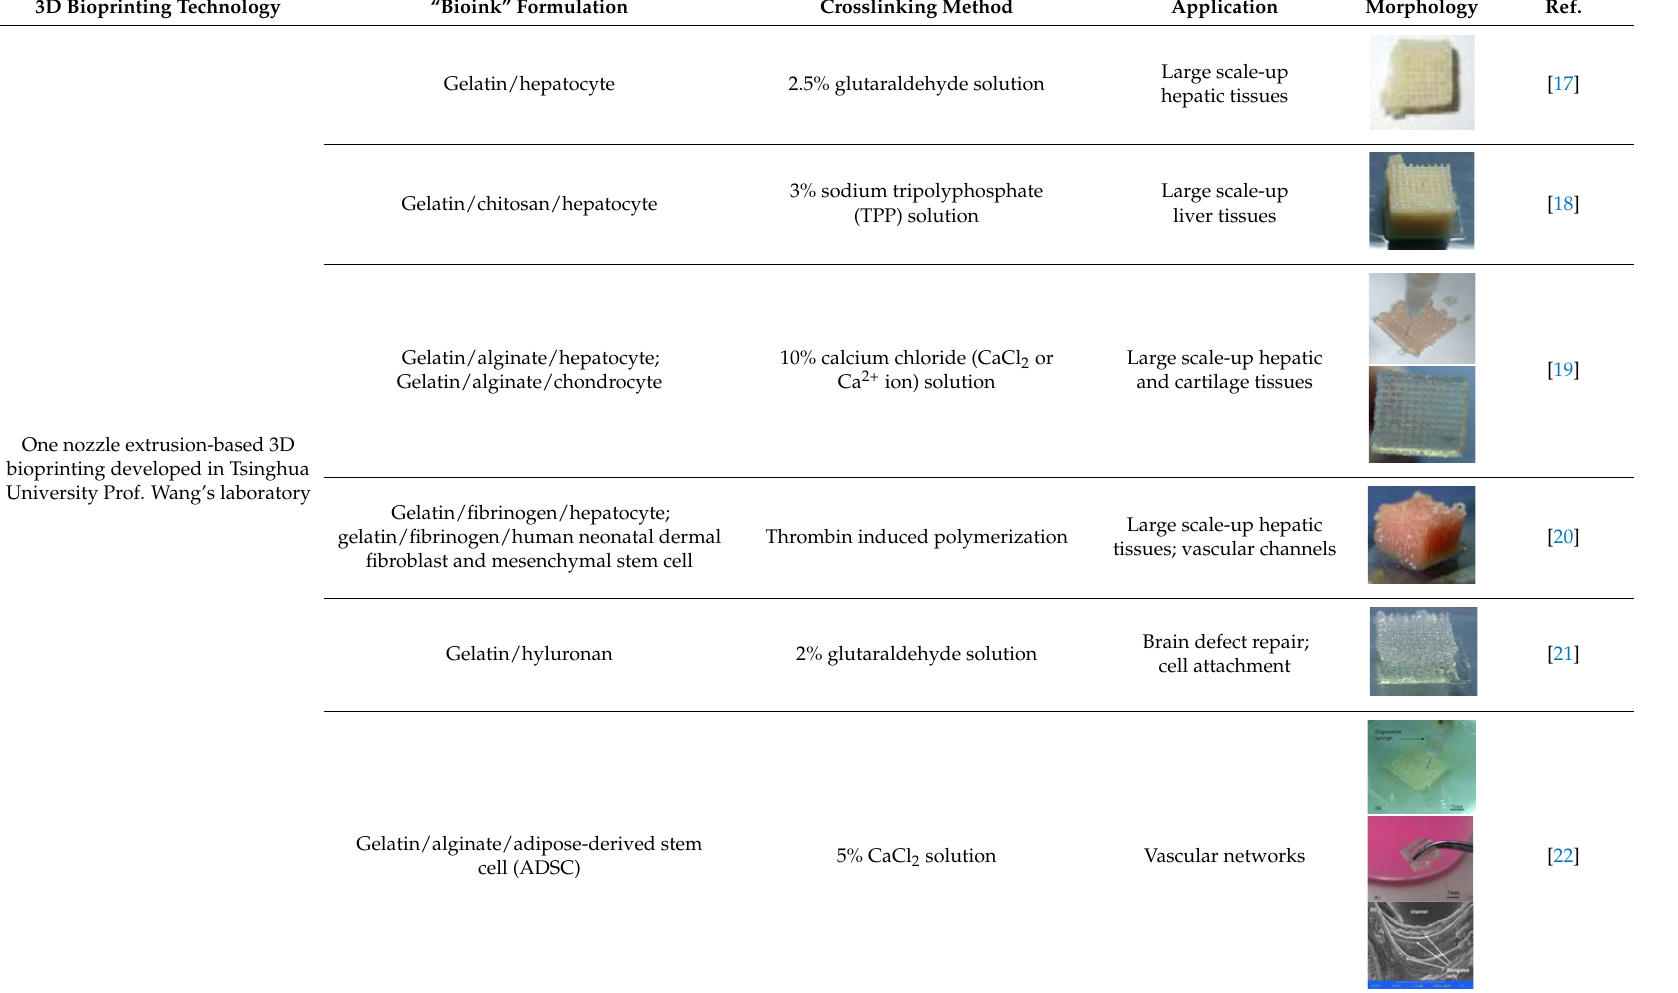
Table 1. Resume of gelatin-based hydrogels for organ 3D printing.